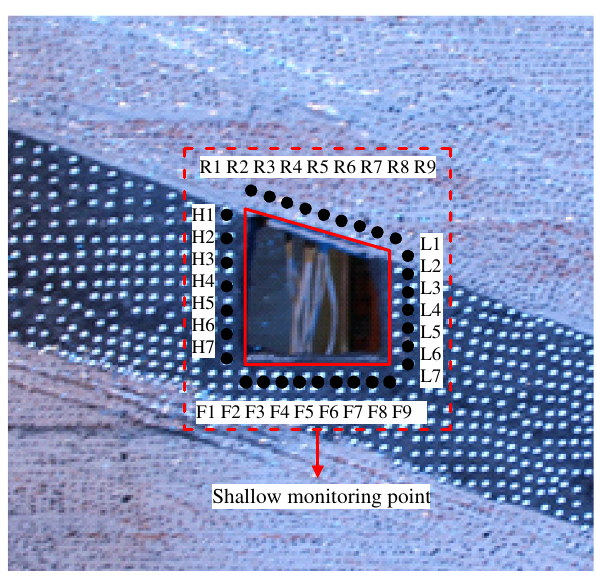
Figure 5. Layout of displacement measuring points of roadway surrounding